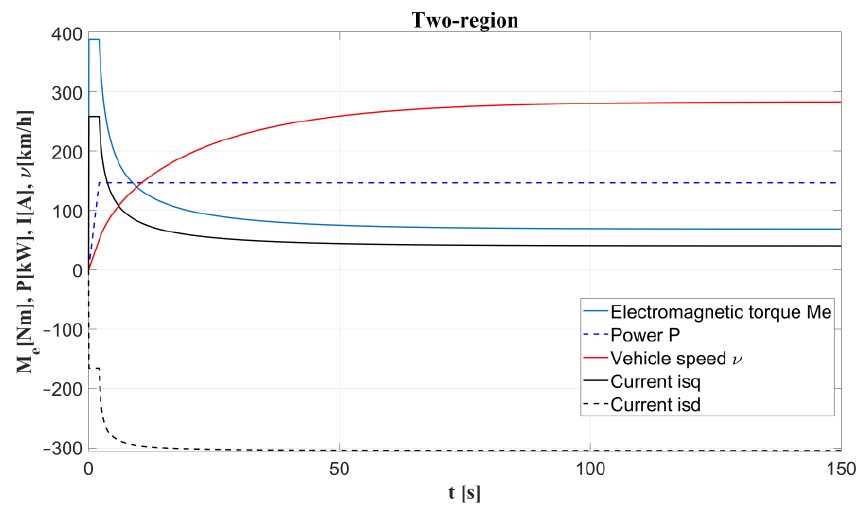
Figure 9. Fisker Karma performance. Dynamics of the two-region motor torque control.